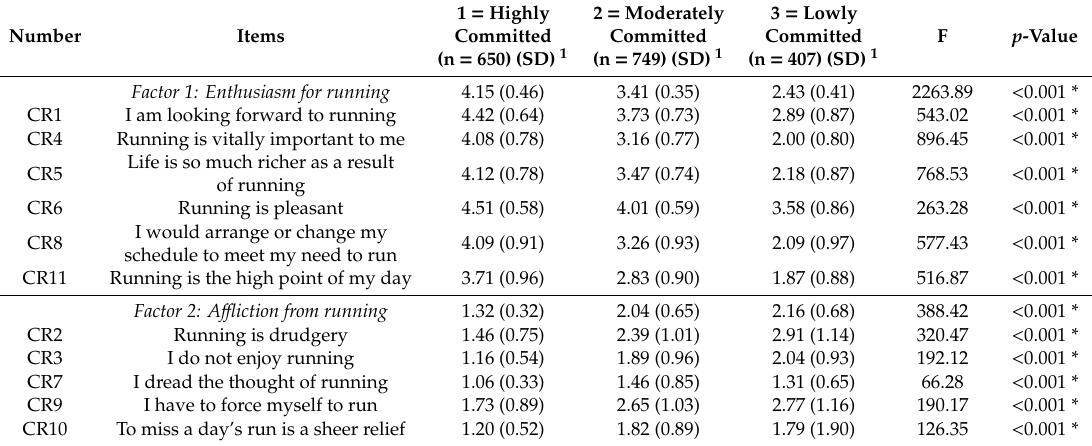
Table 5. Average scores for each variable in the three clusters (obtained through the k-averages